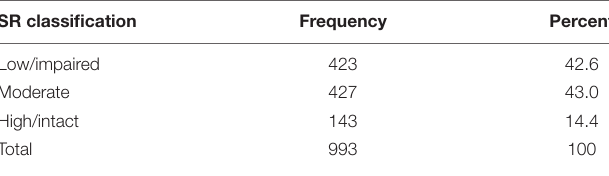
TABLE 3 | Self-regulation classification based on the total score of the